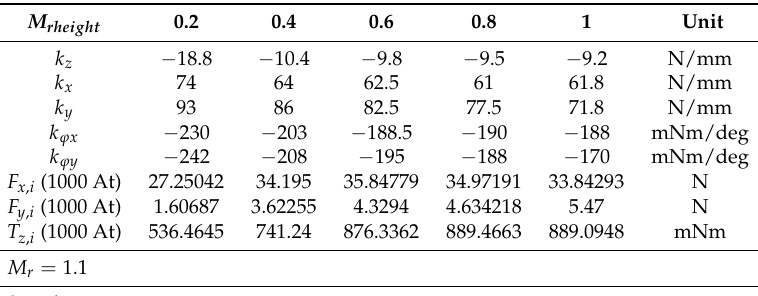
Table 11. Simulation results for different values of M rheight .